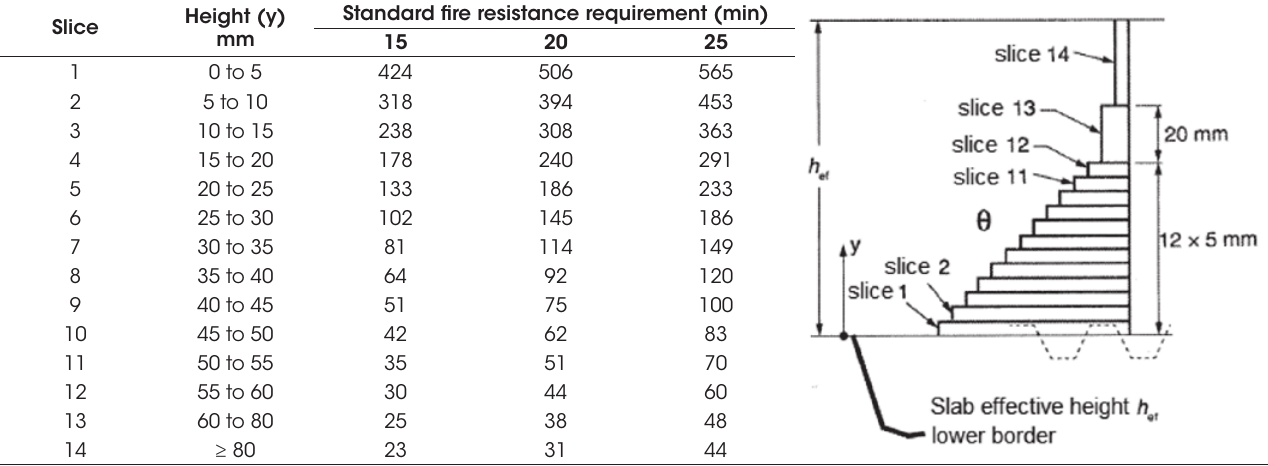
Concrete slab temperature distribution [ºC] for standard fire resistance requirement of less than 30 minutes